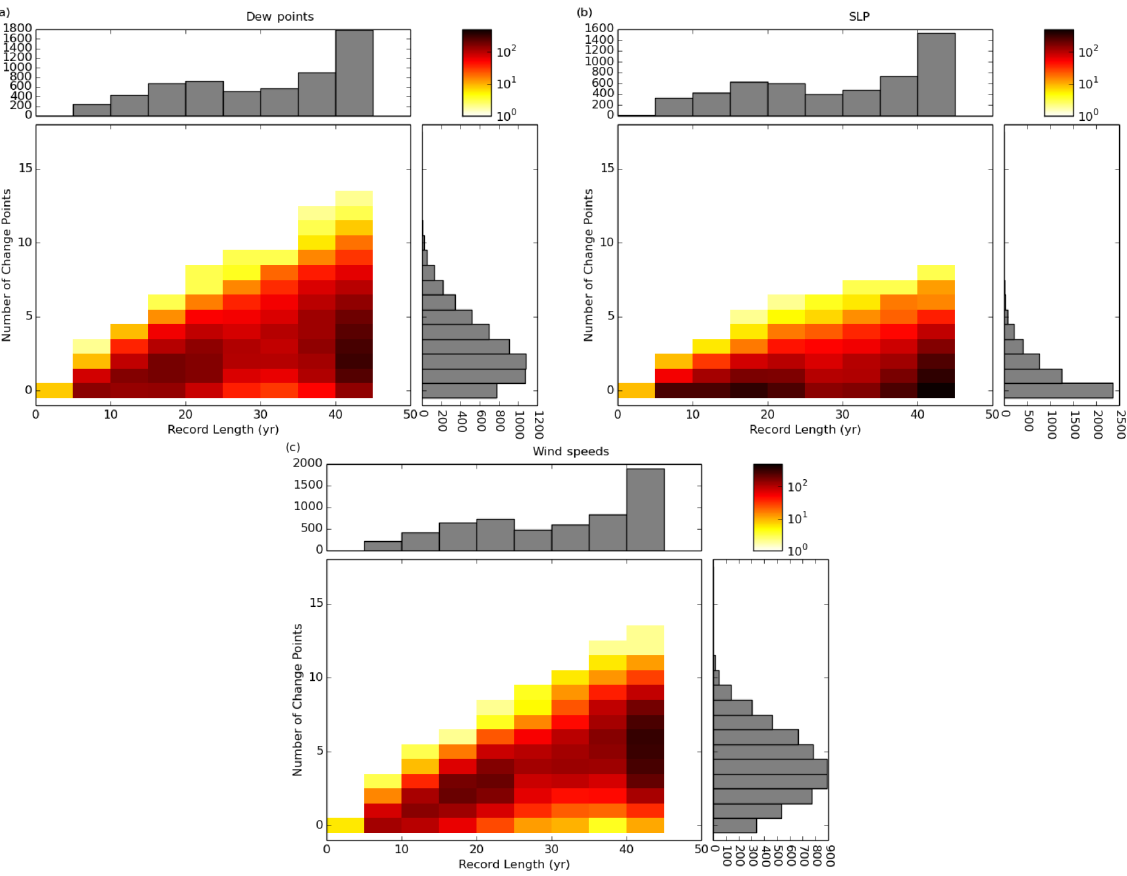
Figure 9. The distribution of the number of change points within a station record against the number of years of data for (a) dew point temperature, (b) sea-level pressure and (c) wind speeds. The histograms on the top and to the right of the grid plot show the projections onto the x and y axes, respectively. The colour bar is on a logarithmic scale.